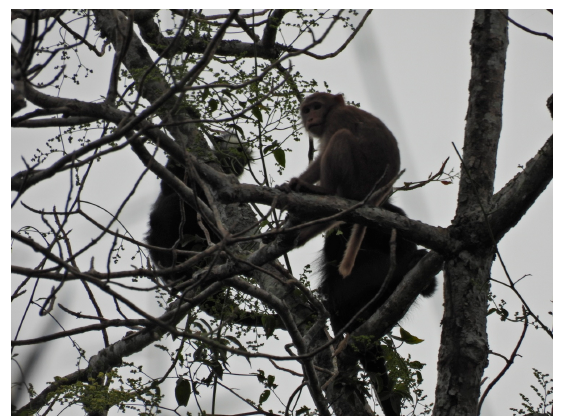
Figure 4. Laotian langur (on the left) and an Assamese macaque (on the right) interacting in the same tree. The two species are sympatric in several sites of the protected area where surveys were carried out.